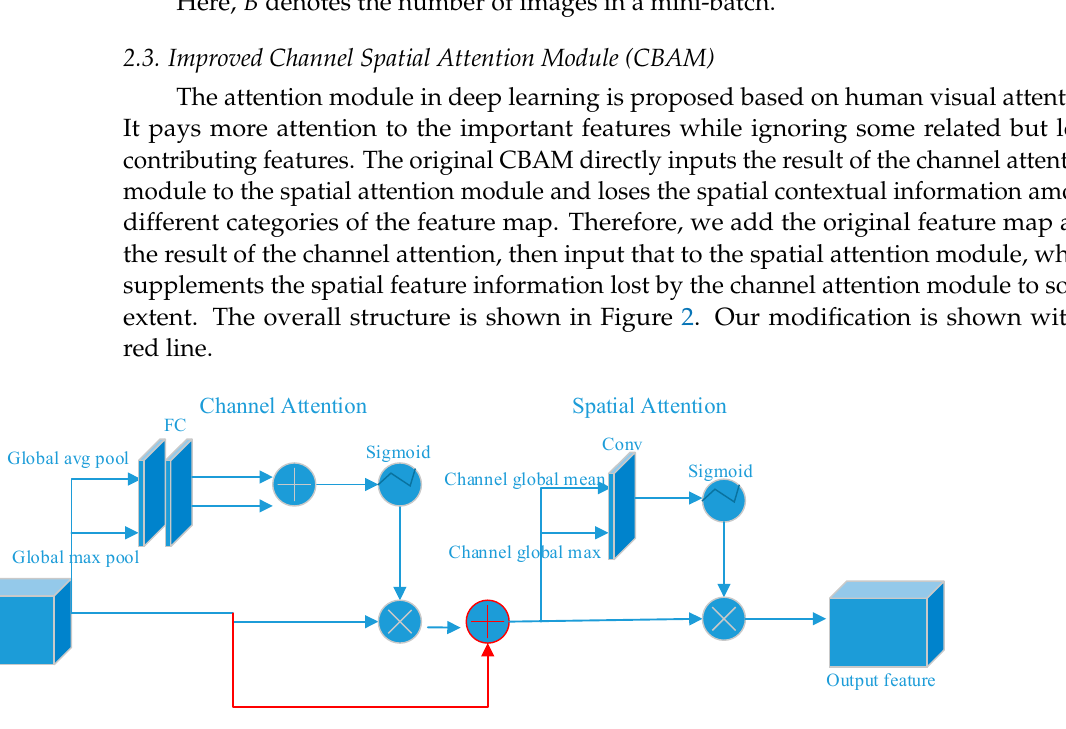
Figure 2. The channel and spatial attention module.